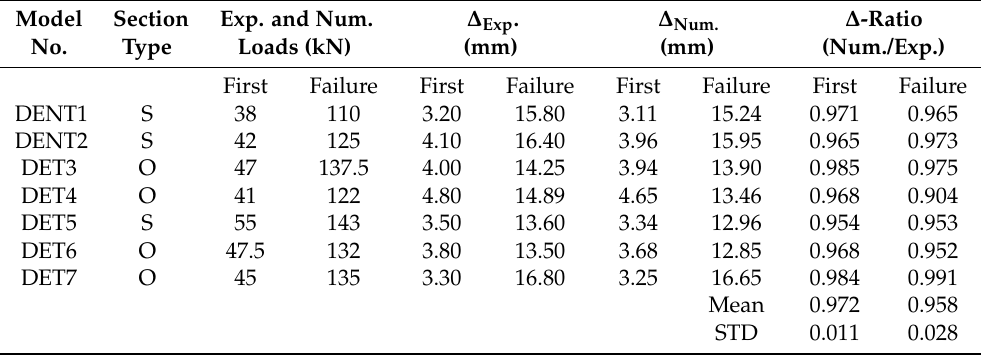
Table 4. Comparison of the experimental and numerical results of the mid-span deflections for the RC girder models with dapped